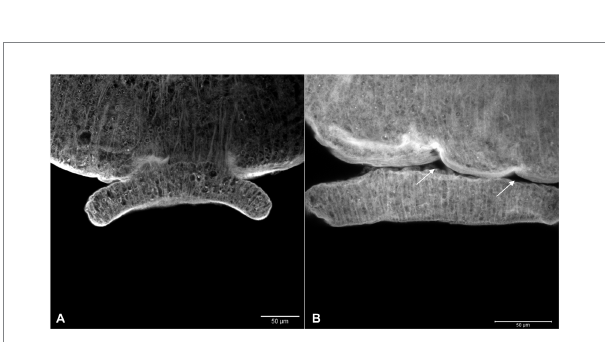
FIGURE 9 Ventral sucker with irregular tegument in ex vivo Sm carm 1 knocked down adult worms. Morphological changes in the ventral sucker of male adult worms recovered from mice infected with schistosomula from (A) negative control and (B) Sm carm 1-dsRNA. The arrows highlight points of the detachment of the ventral sucker to the parasite and white bars indicate the scale 50 μ